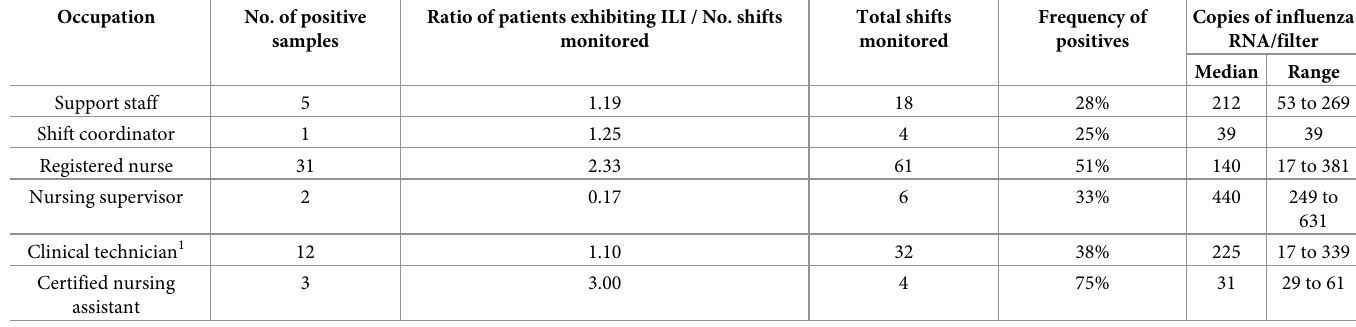
Table 3. Frequency of positive personal bioaerosol samples by occupation.